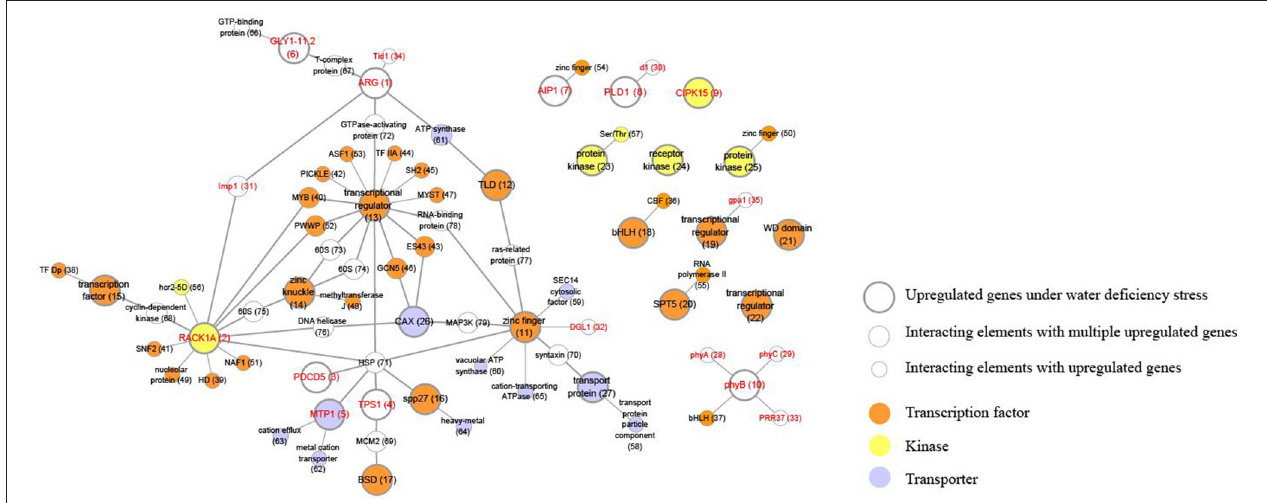
FIGURE 7 | Construction of regulatory network associated with genes up-regulated under WD. Using Rice Interaction Viewer and Cytoscape tools, we queried predicted protein–protein interaction network associated with functionally characterized genes, kinase, transcription factors, and transporters, and identified 10 functionally characterized genes (red lettering in large circle/nodes), 12 TFs (large brown circles/nodes), 4 kinases (large yellow circles/nodes), and 3 transporters (large sky-blue circles/nodes) in network. Furthermore, 32 elements (small circles) interact with upregulated genes under WD (large circles); 20 elements interacting with multiple upregulated genes are indicated by medium-sized nodes and thick lines. Detailed information about values in round brackets of nodes is presented in Table S8 .